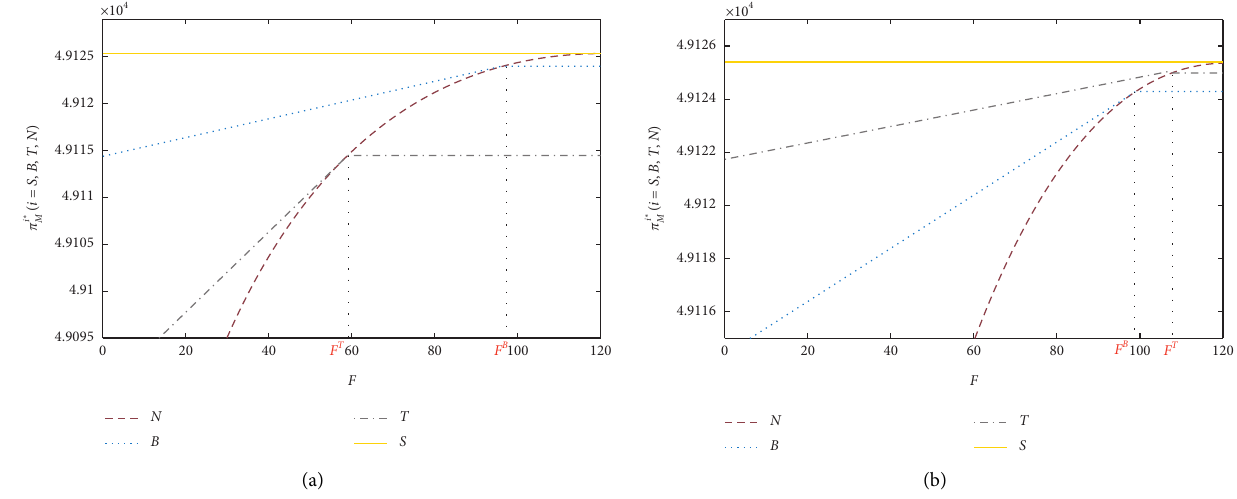
Figure 3: The influence of the initial capital on manufacturer’s profit. (a) θ � 0 . 3. (b) θ � 0 .